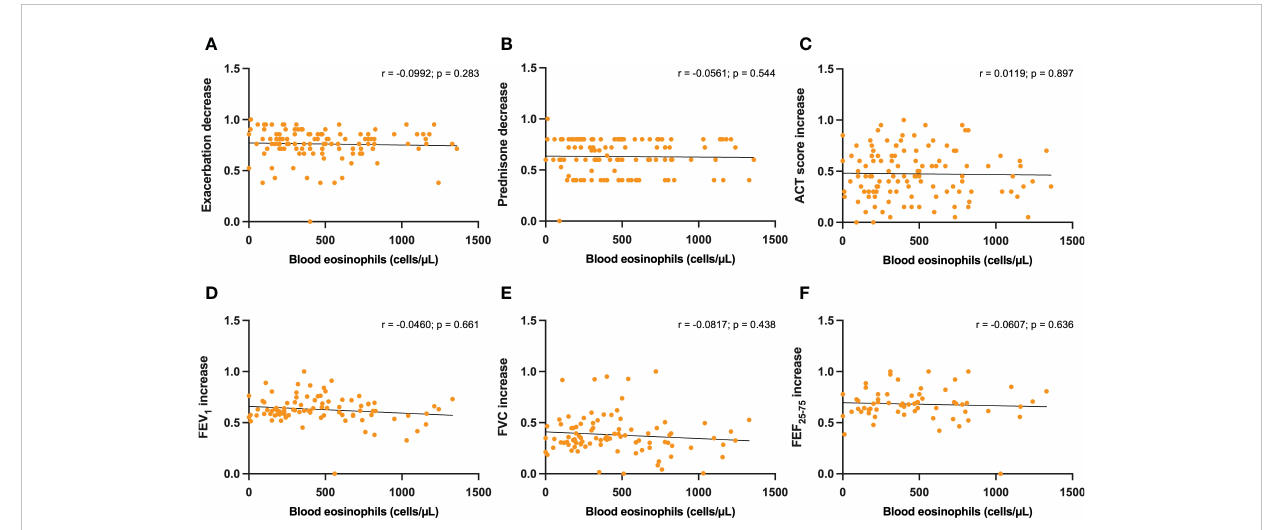
FIGURE 4 Correlations between blood eosinophils and 6-month changes induced by dupilumab, with regard to asthma exacerbations (A) , prednisone intake (B) , ACT score (C) , FEV1 (D) , FVC (E) , and FEF25-75 (F)